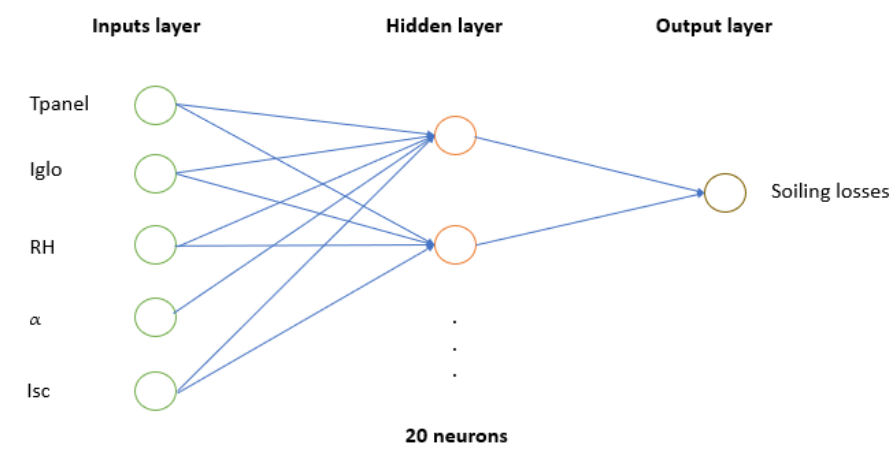
Figure 6. Final Model 2 network.